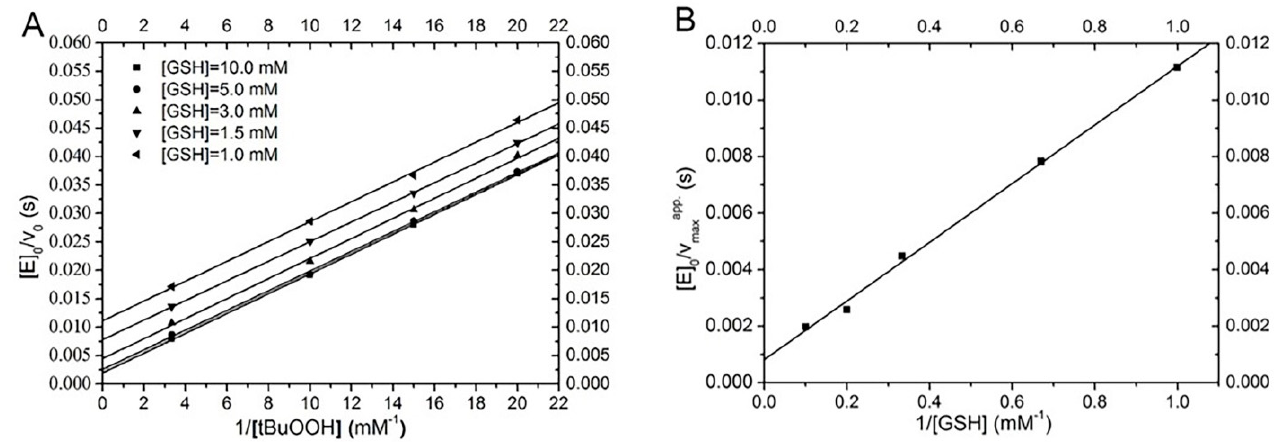
Figure 8. Double − reciprocal plots for the reduction of t − BuOOH with GSH catalyzed by